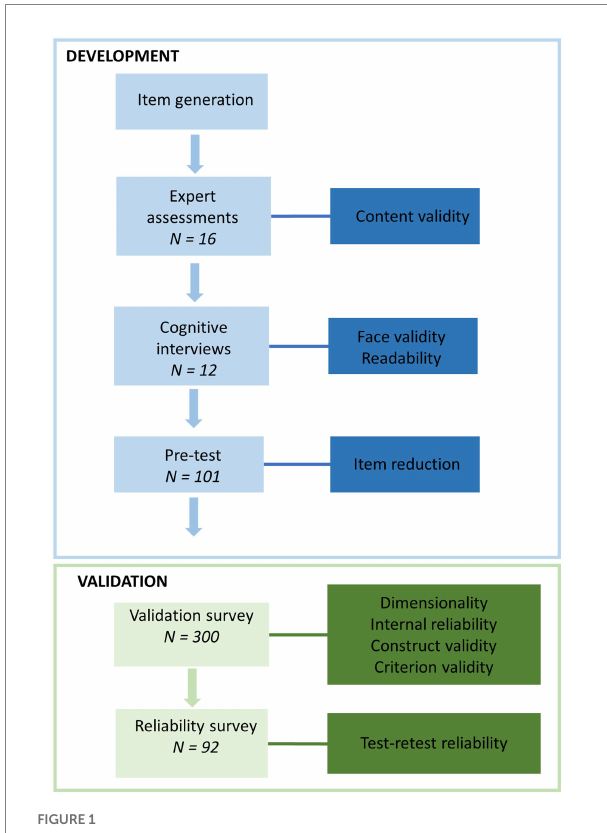
FIGURE 1 Steps in the scale development and validation